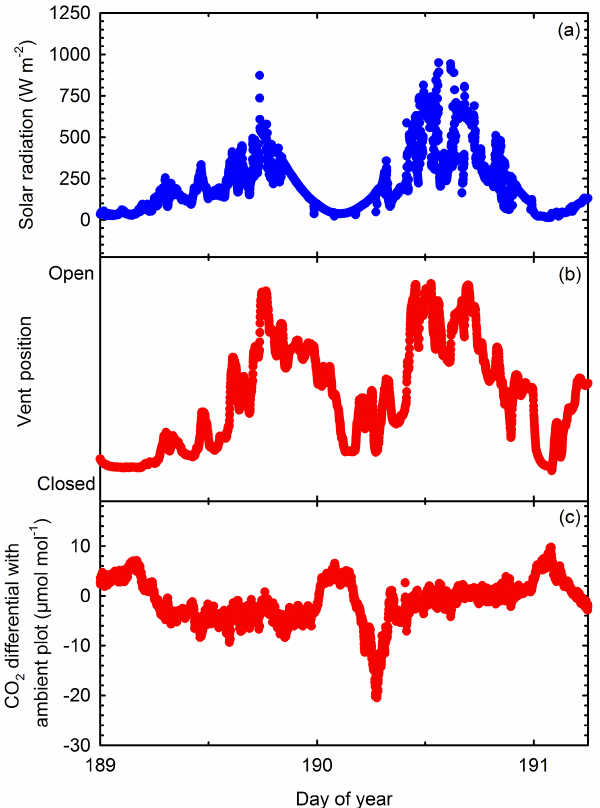
Figure 11. The influence of solar radiation (a) and venting of the ZPW chamber (b) on the carbon dioxide concentration differential between the inside of the ZPW chamber and the ambient plot (c) .